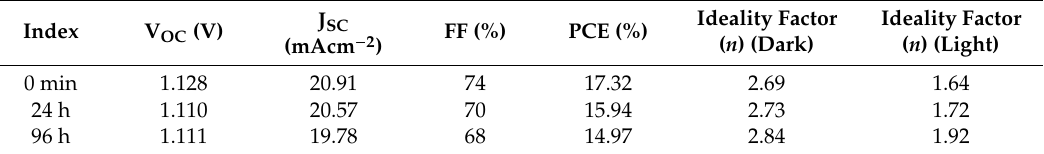
Figure 1. The current–voltage (J–V) measurements of the perovskite solar cell (PSC) as a function of time under ( a ) AM 1.5 G light intensity and reverse scanning. ( b ) Dark J–V curves of the corresponding devices at room temperature. Light intensity dependence of ( c ) short-circuit current density (J SC ) and ( d ) V OC under reverse scanning in the investigated devices. Table 1. Photovoltaic parameters of the investigated PSC aged over time (reverse scanning). FF: fill factor; PCE: power conversion efficiency.